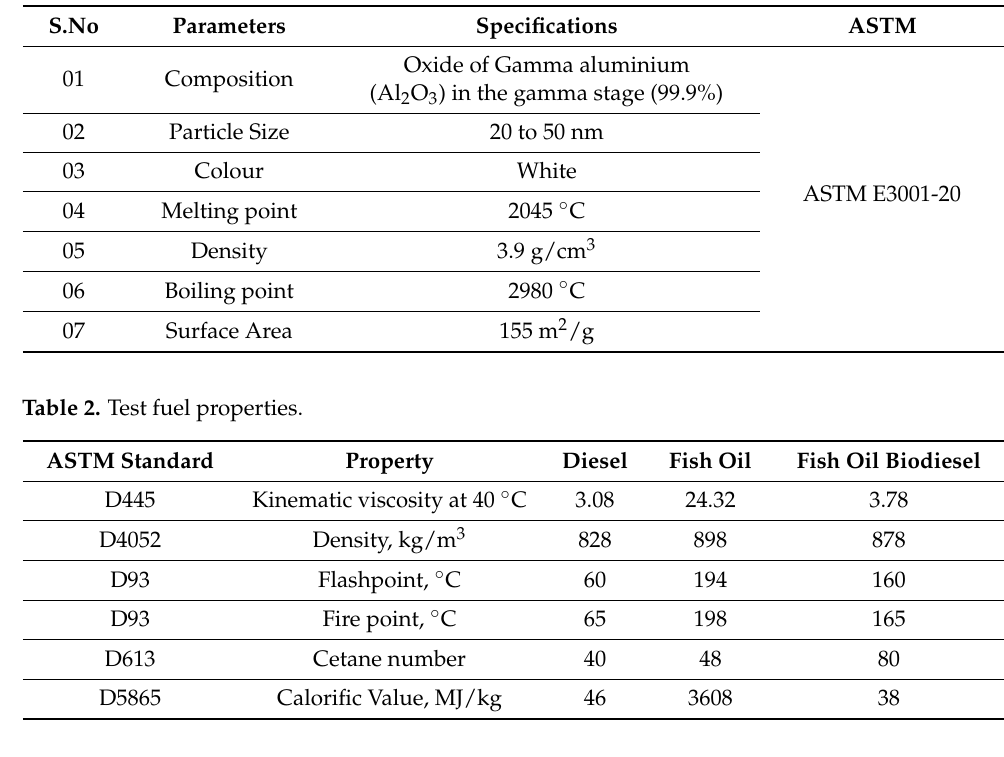
Table 1. Aluminium oxide nanoparticle specifications.